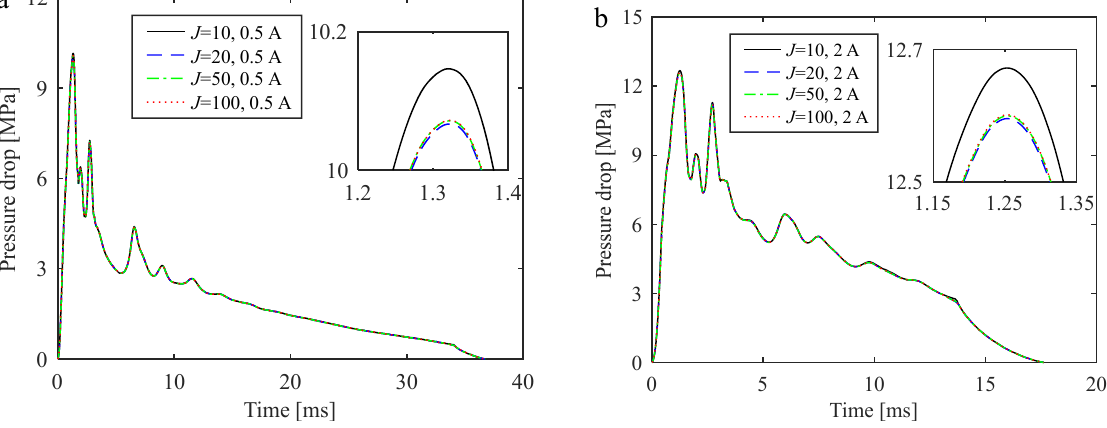
Figure 25. Peak velocity profiles of the activated region and its local enlargement for different mesh density under the excitation current of 0.5 A.